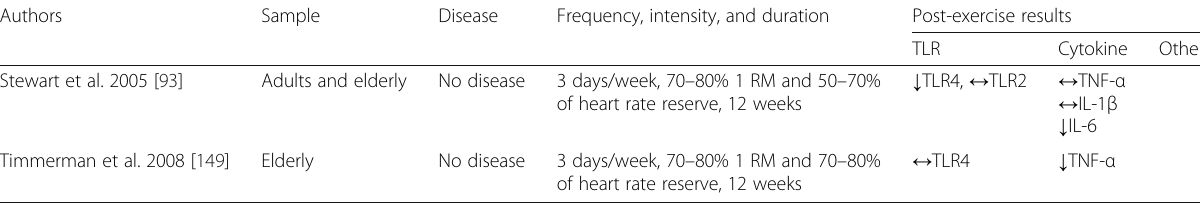
Table 8 Modulation of TLR2 and TLR4 after combined exercise (aerobic and resistance)